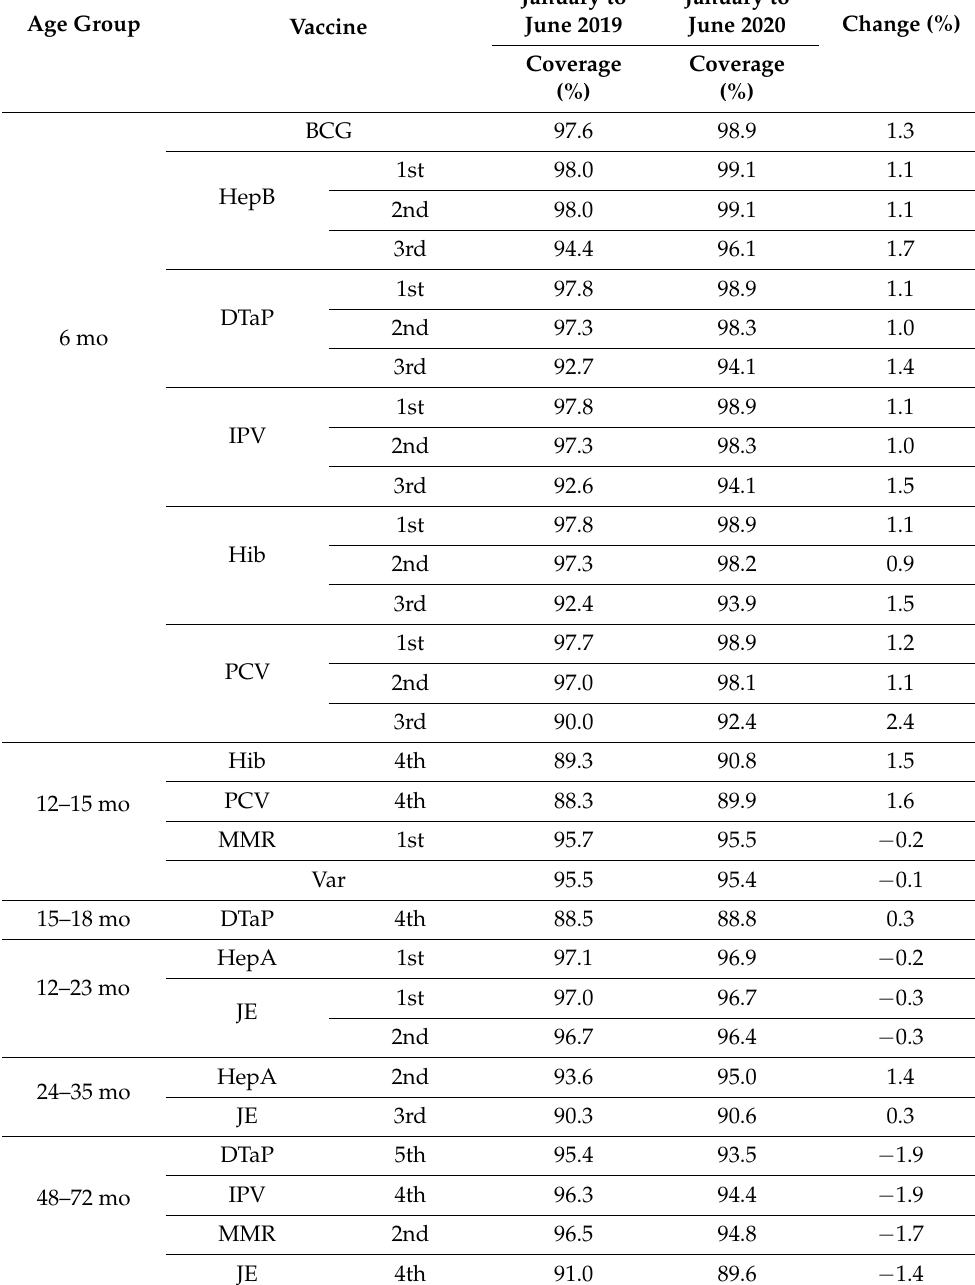
Table 1. Comparison of vaccination coverage in January to June 2019 and January to June